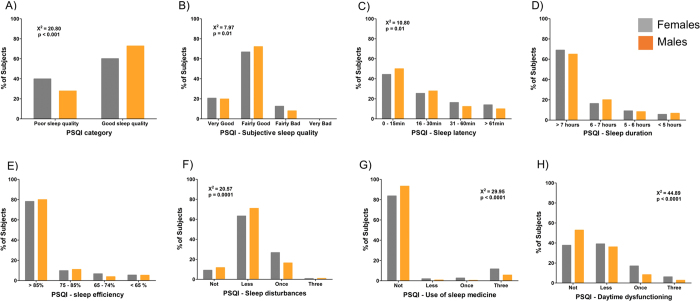
Frequency distribution for PSQI category and components by sex.(A) PSQI category. Subjects with scores ≥5 were classified as having poor sleep quality. A higher frequency of women presented poor sleep quality Χ2 = 20.80; p < 0.001. (B–H) show PSQI components. (B) Subjective sleep quality. There was a sex effect on how subjects rated their sleep, with women tending to declare poorer sleep quality X2 = 7.97; p < 0.05. (C) A higher proportion of women reported longer sleep latency X2 = 10.81; p < 0.05. (D) Sleep duration and (E) sleep efficiency, no statistical difference between the sexes. (F) Sleep disturbances, women were more prone to declare having sleep disturbances during the last month X2 = 20.37; p < 0.001; (G) Use of sleep medication: Men declared less use of sleep medication than women during the last month X2 = 29.95; p < 0.00. (H) Daytime dysfunction: A higher proportion of women declared having daytime dysfunction during the last month X2 = 44.89; p < 0.0001.